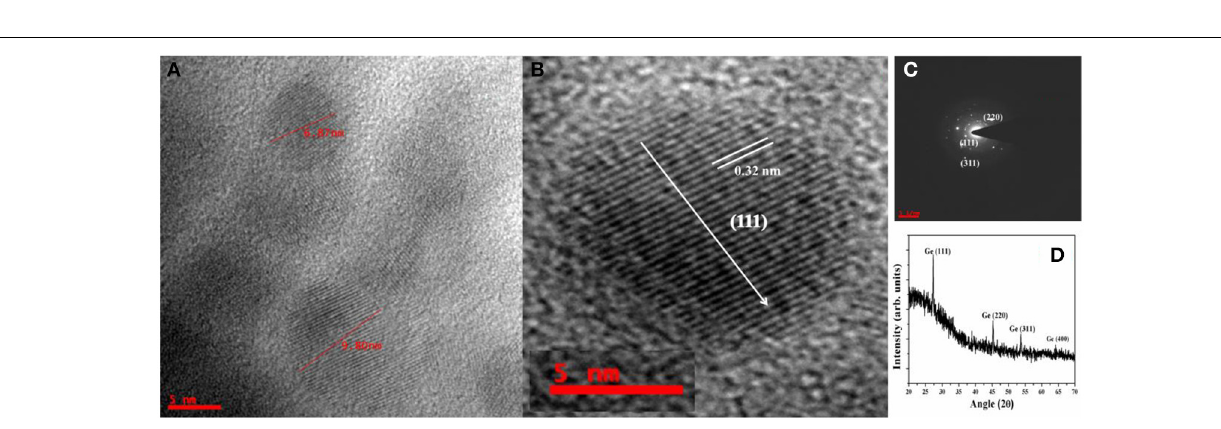
FIGURE 5 | (A) High resolution TEM image of Ge nanoparticles and (B) HRTEM image of single Ge NP, (C) the corresponding SAED pattern of Ge NPs and (D) XRD pattern of the drop casted Ge NPs solution (acetone) on the glass